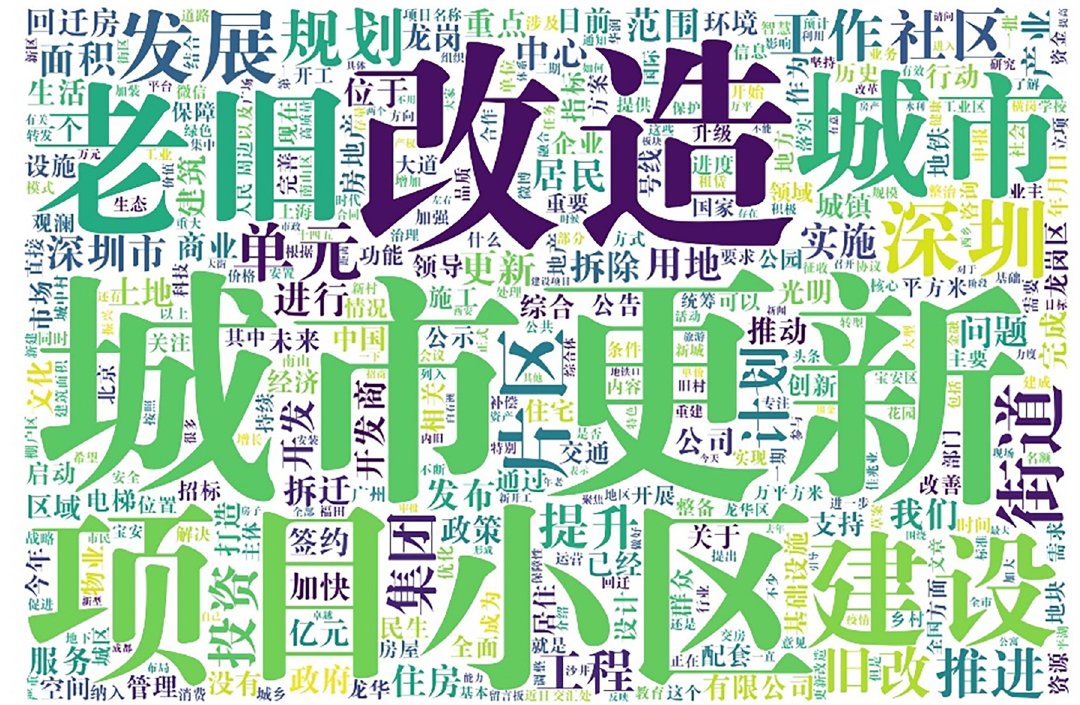
Fig 9. WC visualization of the top 400 most frequently posted Chinese words out of all 74,481 Chinese words.